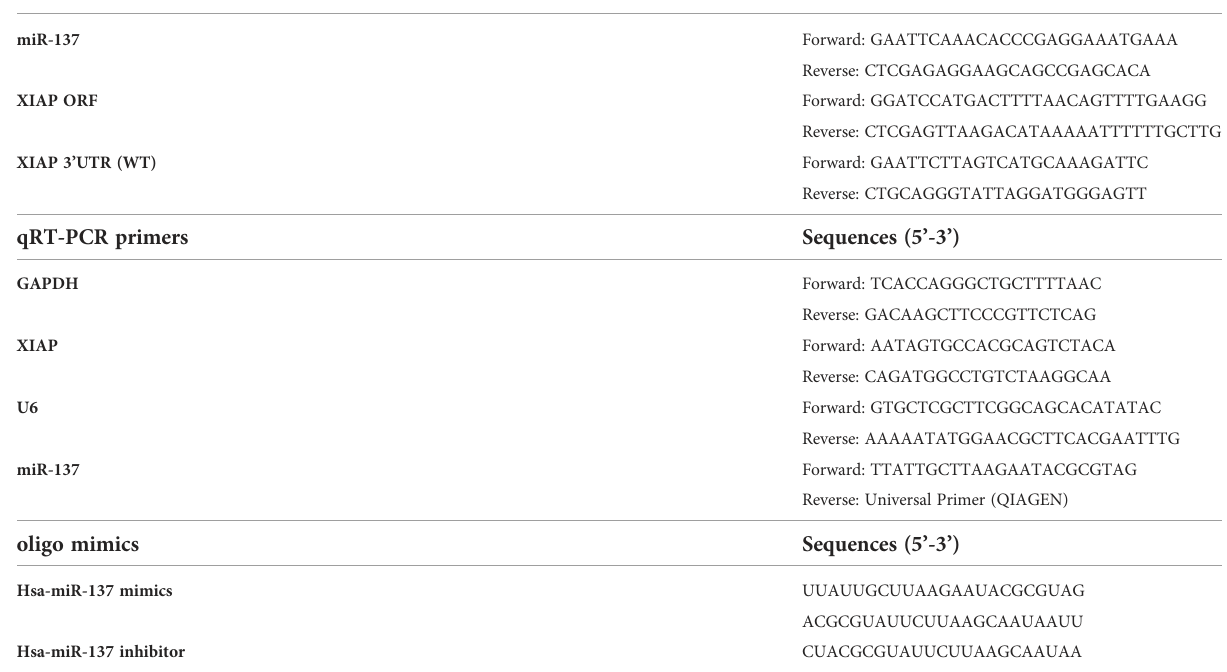
TABLE 1 Oligos used for PCR and transfection. primers for PCR